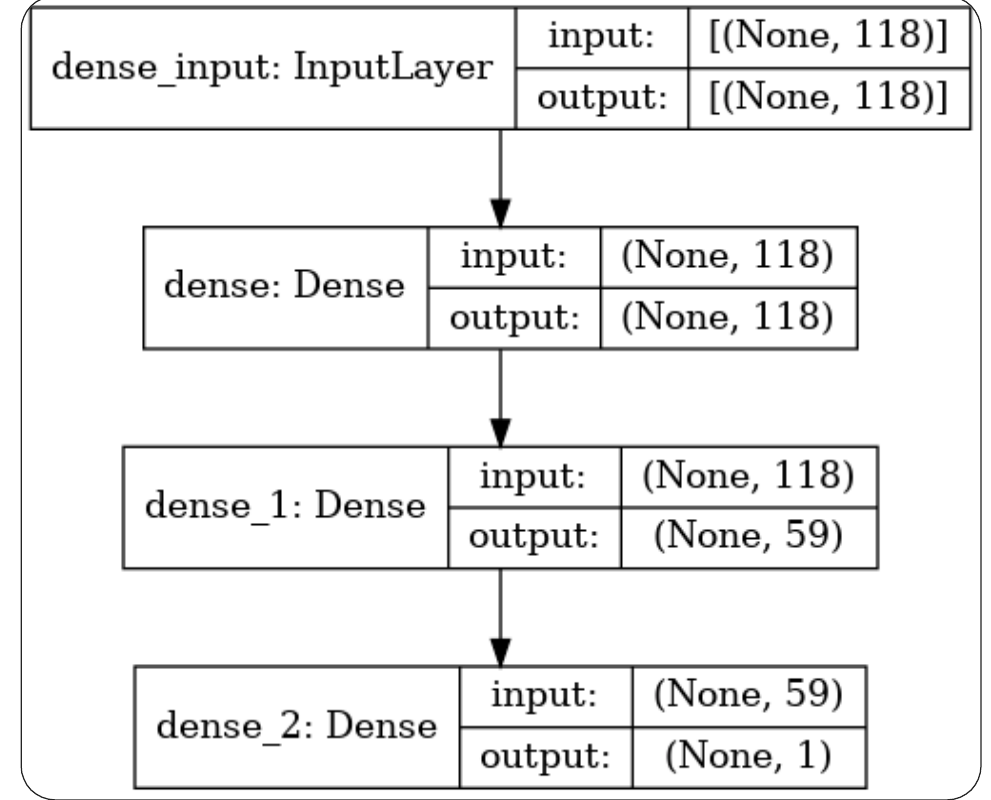
Figure 8. The ANN